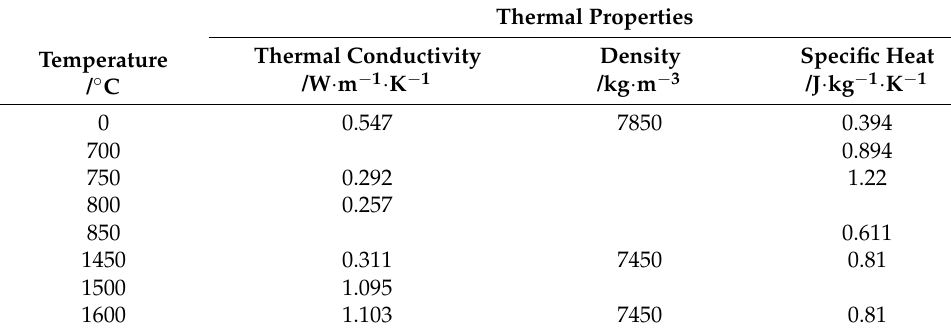
Table 2. Thermal properties of S355J2 + N steel.